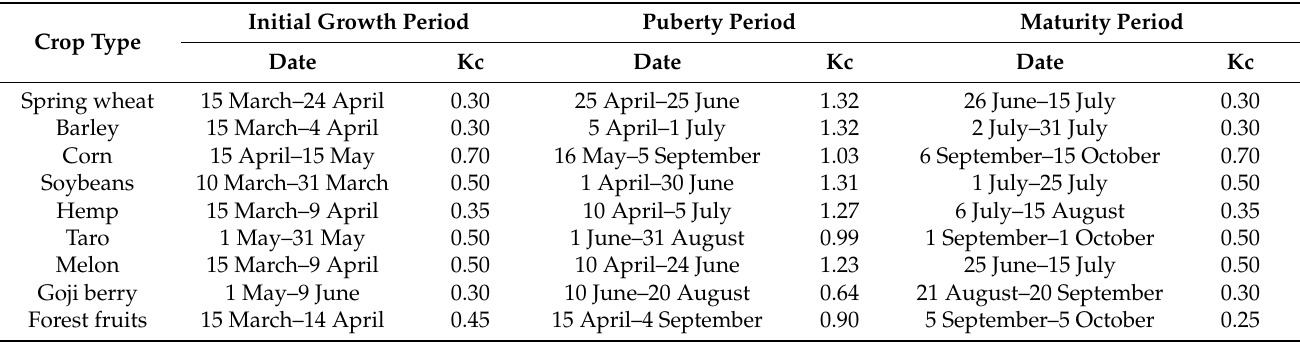
Table 1. Crop coefficient for Jingdian Irrigation District.